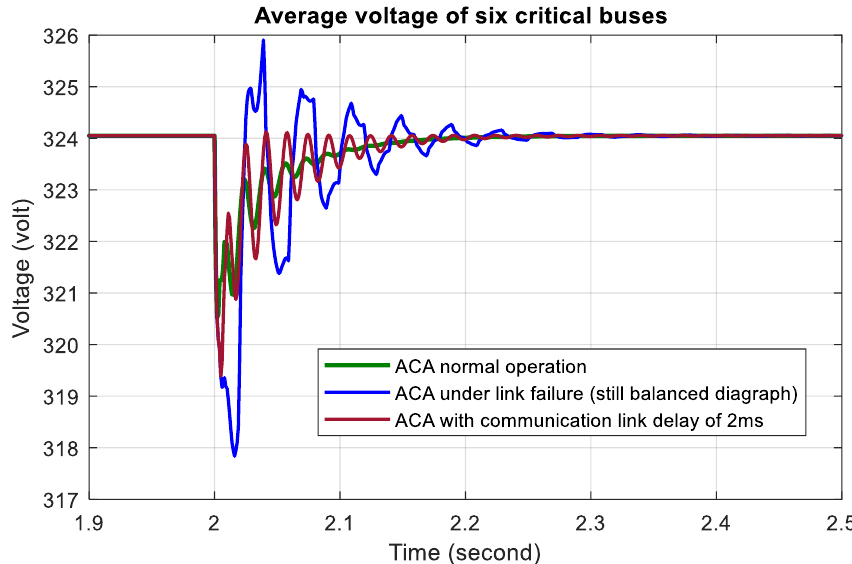
Figure 23. Average Voltage of the Pilot Buses under Different Operation Scenarios.